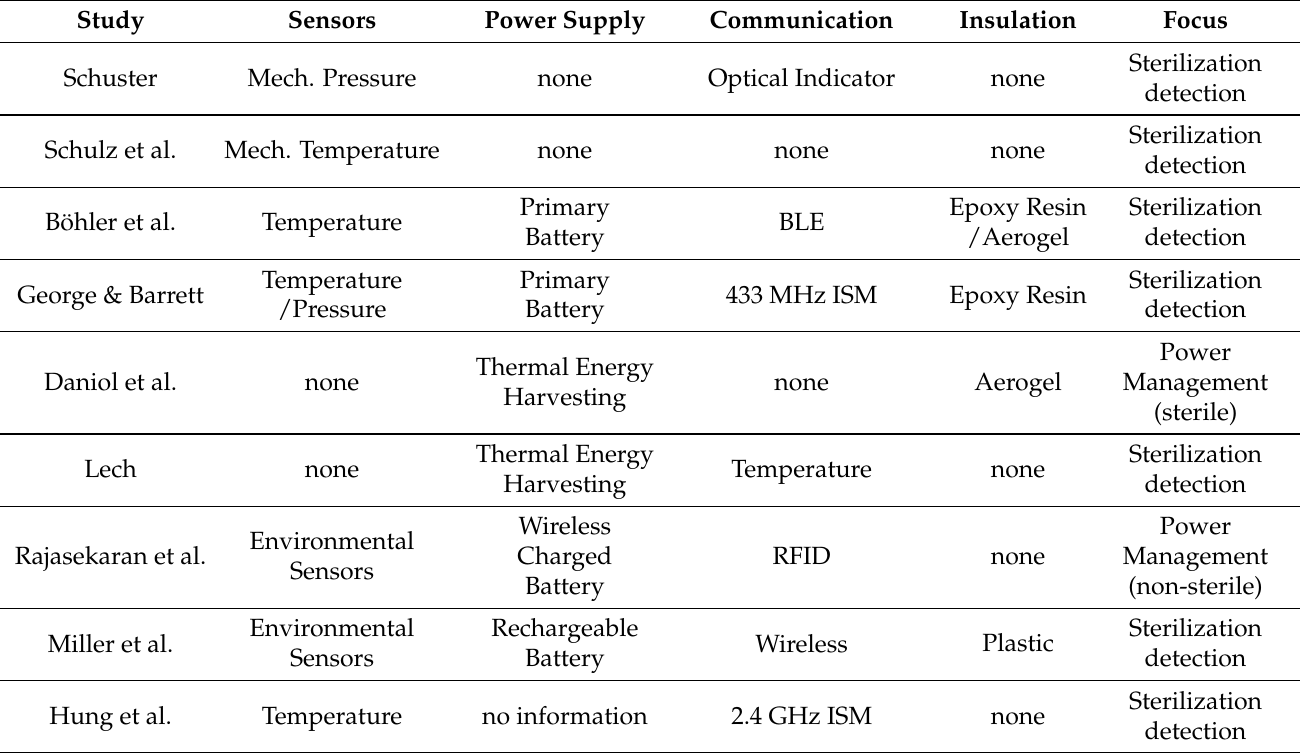
Table 1. Overview of the state of the